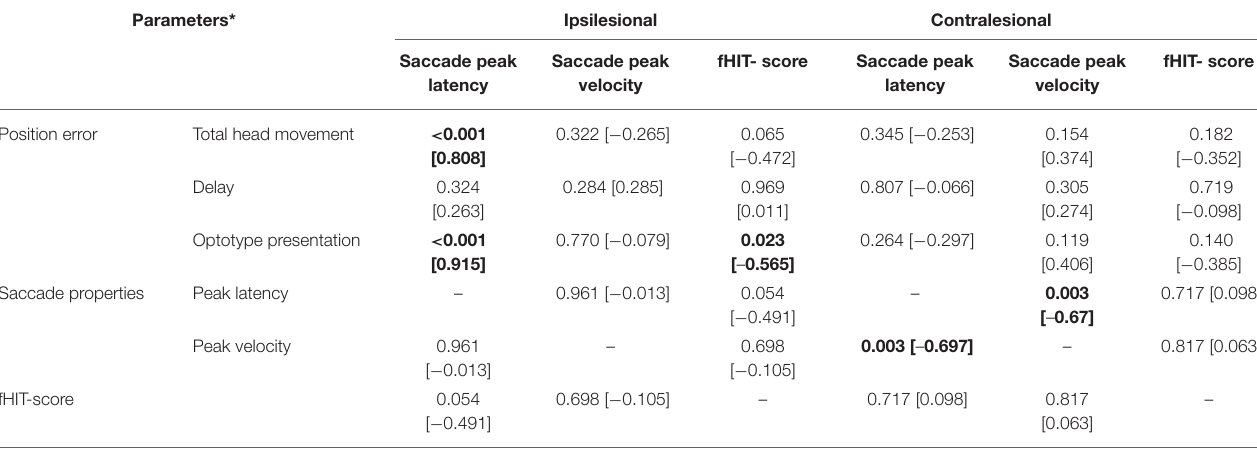
fHIT- score velocity